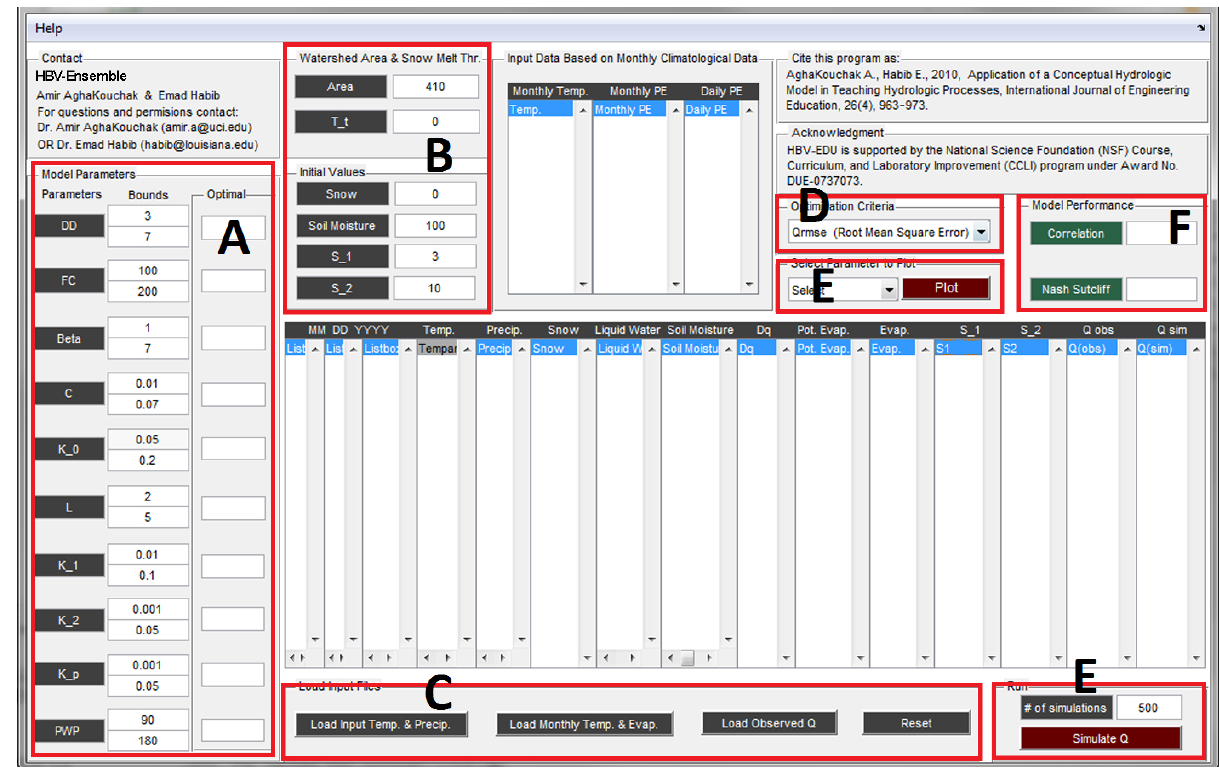
Fig. 1. HBV-Ensemble Graphical User Interface (GUI): (A) model parameters; (B) initial values and constants; (C) input data loading tools; (D) objective functions including root mean square error, Nash–Sutcliffe coefficient and correlation coefficient; (E) number of ensemble members; (F) model performance; (G) plotting tools.